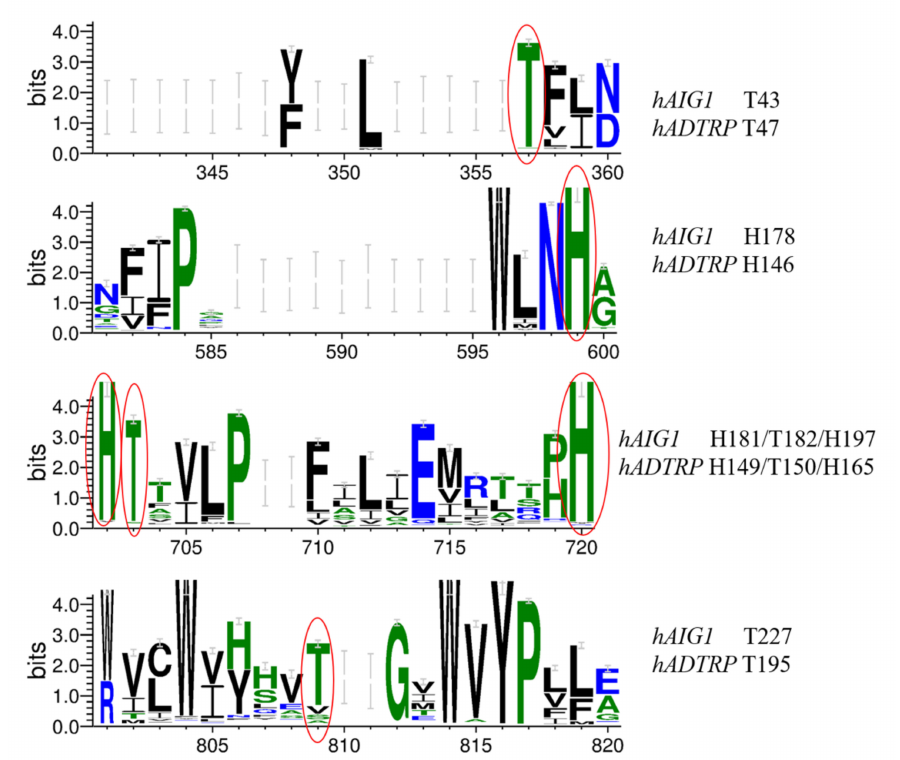
Figure 5. Graphical representation of the conserved amino acid sites across all available AIG protein sequences. The conserved sites are marked with red